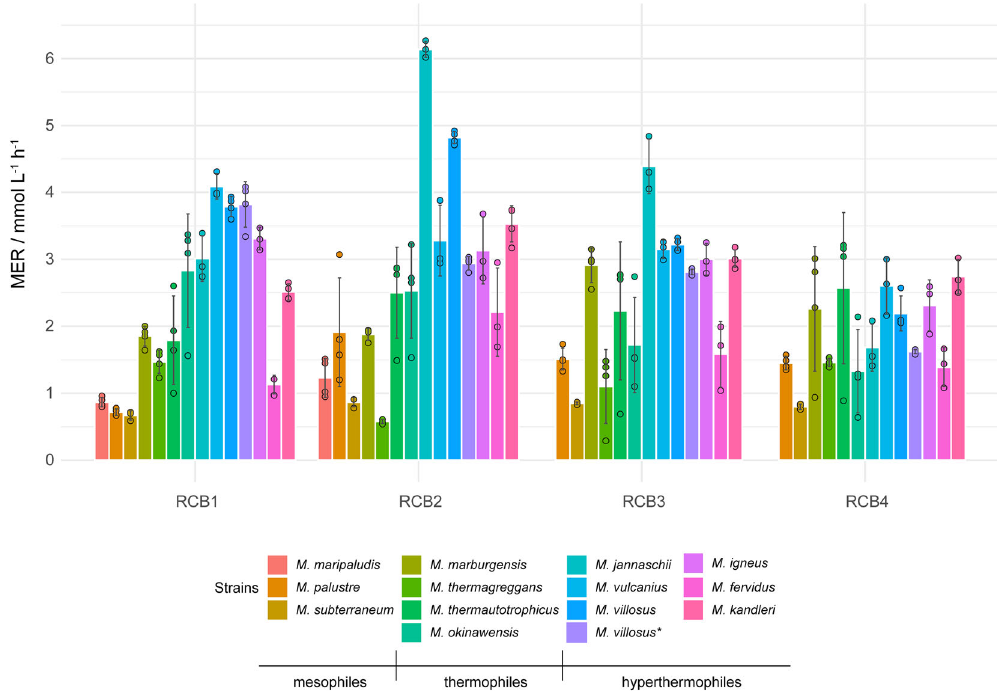
Fig. 3 Results of high-pressure RCB cultivations of prioritized methanogens in the simultaneous bioreactor system (SBRS) at 10 bar. All experiments were performed in quadruplicates in the SBRS system at a gassing ratio of H 2 /CO 2 (4:1) 35 . Mean and standard deviation are shown. The principle of the cultivation was to repressurize each of the bioreactors to 10 bar after full headspace gas conversion. RCB1, RCB2, RCB3, and RCB4 indicate results from individual and successive closed batch headspace gas conversions. MER / mmolL − 1 h − 1 is shown. The left block indicates mesophilic methanogens grown at 37 °C ( Methanococcus maripaludis S2, Methanobacterium palustre F, Methanobacterium subterraneum A8p); the middle block shows the thermophilic methanogens grown at 65 °C ( Methanothermobacter marburgensis Marburg, Methanobacterium thermaggregans , Methanothermobacter thermautotrophicus DeltaH, Methanothermococcus okinawensis IH1); and the right block shows hyperthermophilic methanogens ( Methanocaldococcus jannaschii JAL-1 (80 °C), Methanocaldococcus vulcanius M7 (80 °C), Methanocaldococcus villosus KIN24-T80 (80 °C), Methanocaldococcus villosus KIN24-T80*-grown on 282c 18_E medium (80 °C), Methanotorris igneus Kol 5 (85 °C), Methanothermus fervidus H9 (80 °C), Methanopyrus kandleri AV19 (98